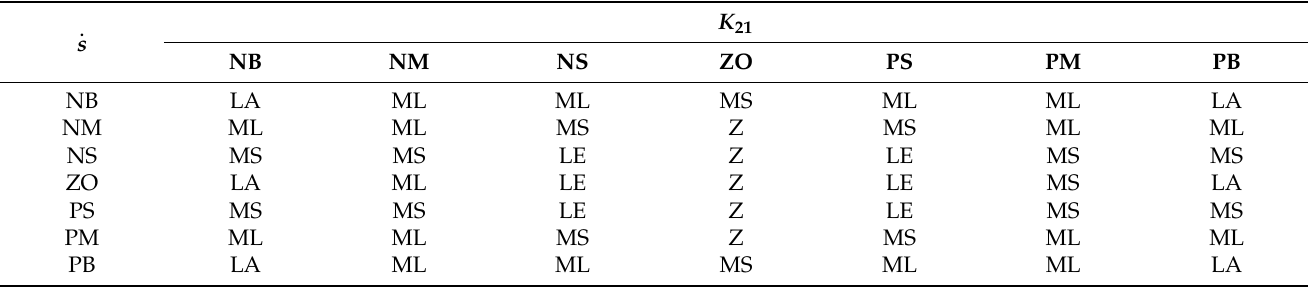
Table 2. The fuzzy control rules.